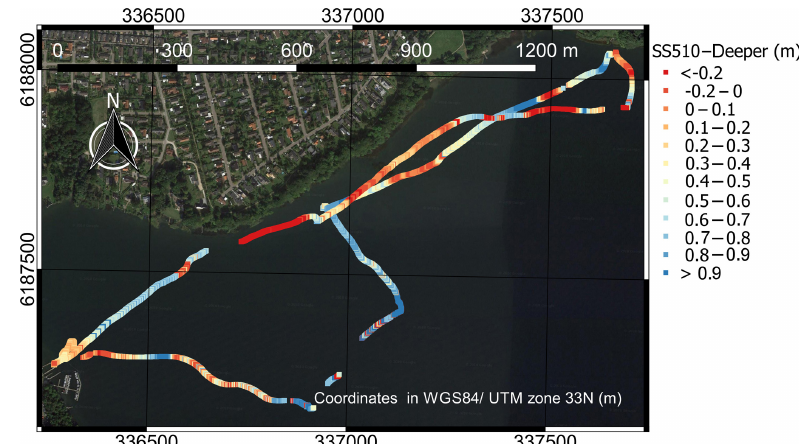
Figure 7. Difference between water depth measured by SS510 sonar and the Deeper